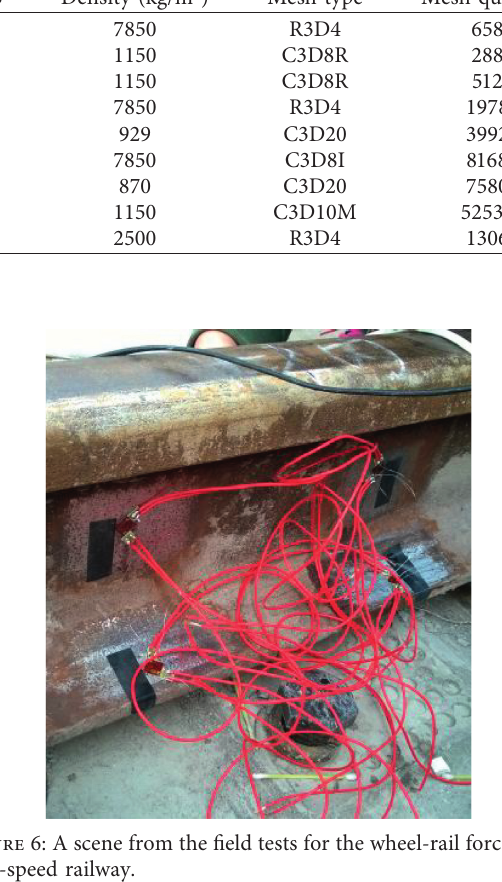
Table 1: Material properties, mesh types, and mesh quantities of all components except the clip. Component